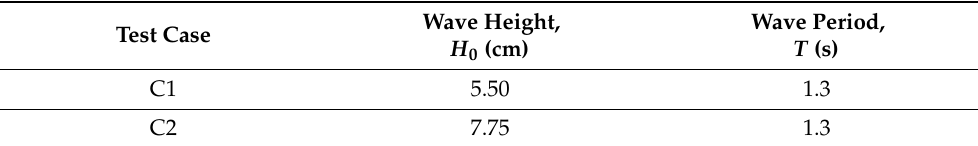
Table 2. Incident wave characteristics of the two simulated